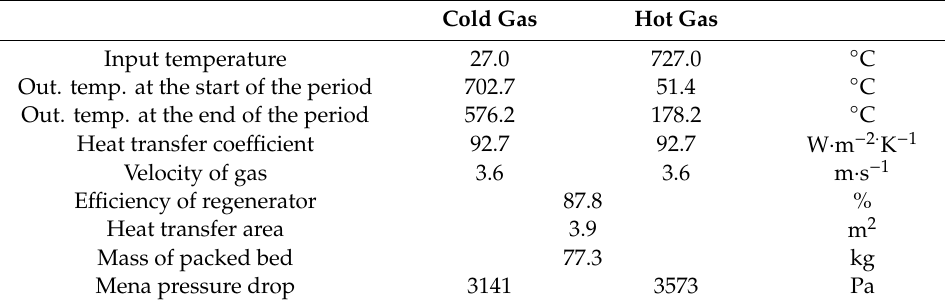
Table 6. Basic results of the calculation.